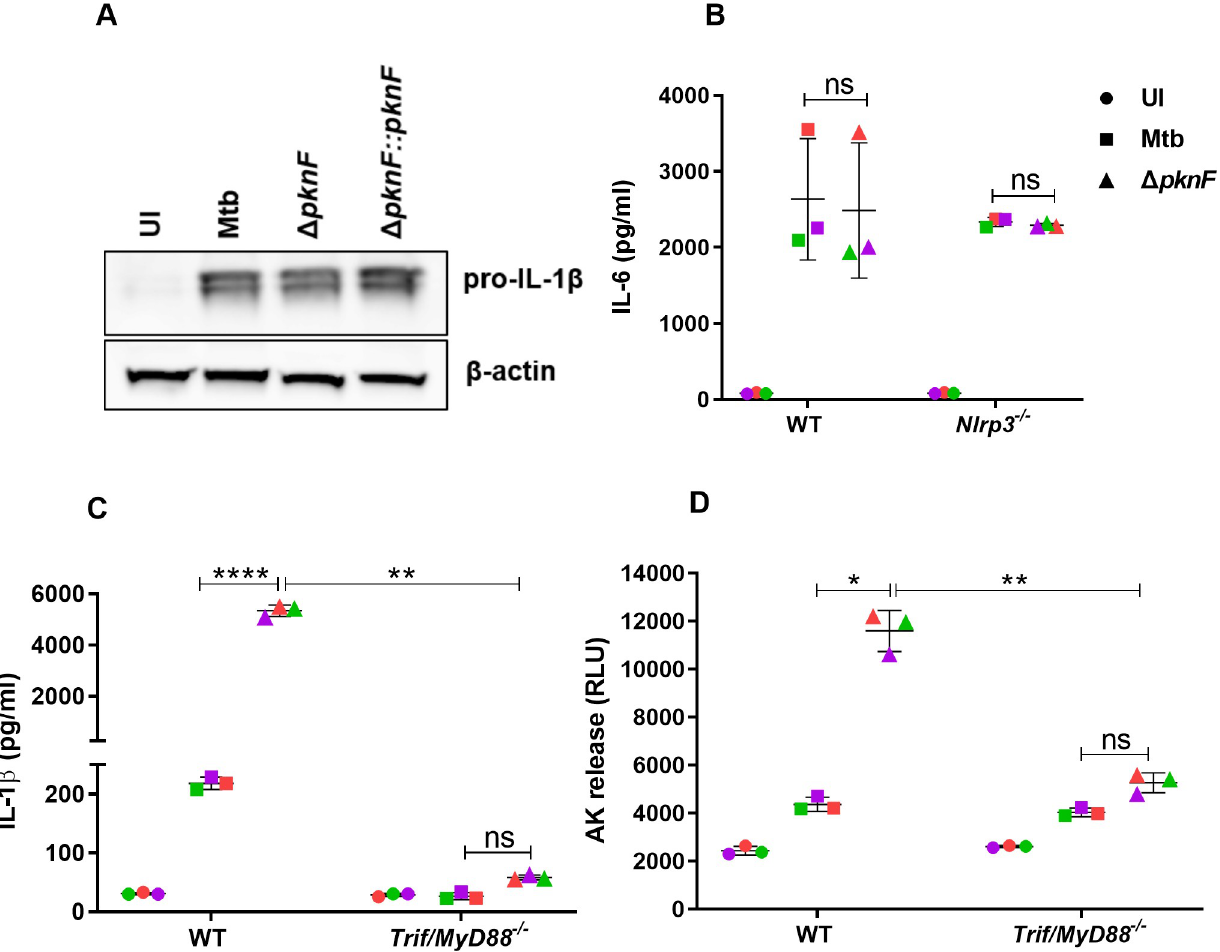
Fig 5. The pknF Mtb mutant induces increased NLRP3 inflammasome activation independently of transcriptional priming. BMDMs were either left uninfected (UI) or infected with different CDC1551 Mtb strains (Mtb, Δ pknF mutant and complement Δ pknF :: pknF ) at an MOI of 10. Cell lysates were prepared at 4 hpi and performed (A) Western blot analysis for pro-IL-1 β (34 kDa) and β -actin (42 kDa). Data is representative of one independent experiment out of three independent biological replicates. BMDMs derived from wild type (WT), Nlrp3 -/- and Trif -/- /Myd88 -/- mice were either left uninfected (UI, solid circles) or infected with Mtb (solid squares) and Δ pknF mutant (solid upright triangles). Culture supernatants were harvested at 20 hpi and analyzed for (B) IL-6 secretion by ELISA (C) IL-1 β secretion and (D) cell death by measuring the release of cytosolic enzyme, adenylate kinase (AK). Data are representative of three independent biological replicates. Each colored data point represents average of technical replicates for each of the biological replicate (n = 3). Error bars represent mean ± SD; � , p < 0.05, �� , p < 0.01, ���� , p < 0.0001, ns (non-significant).